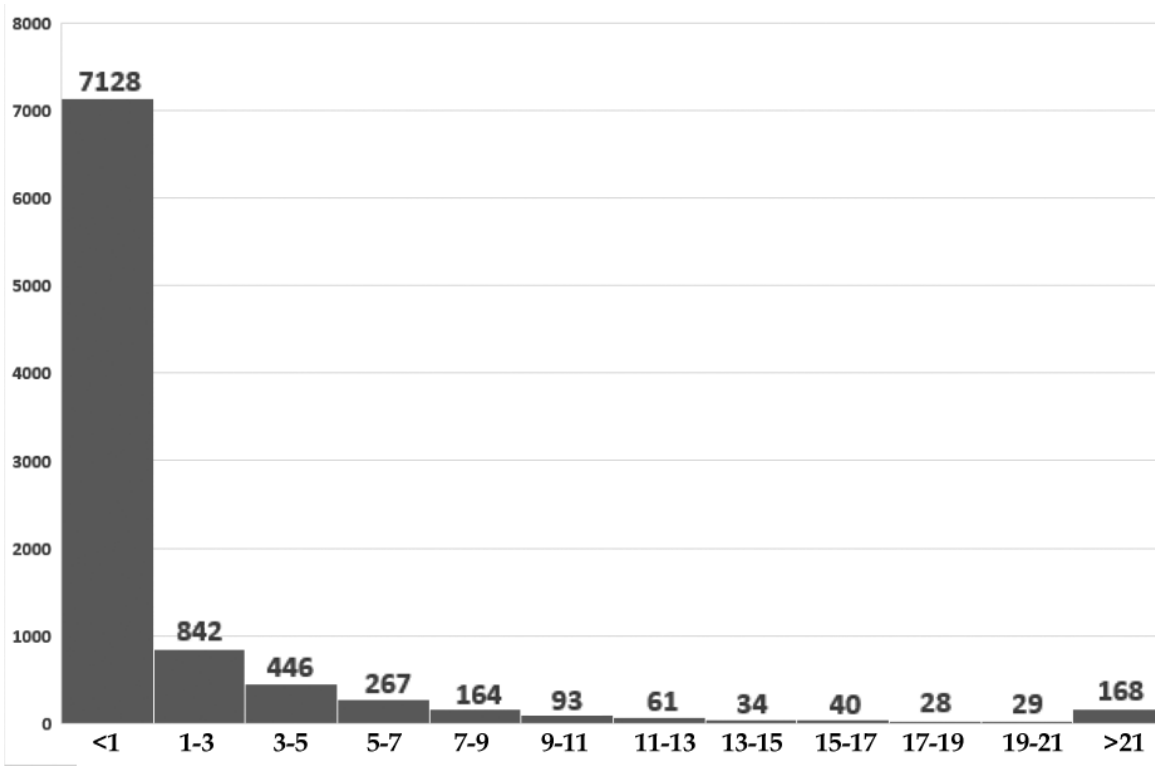
Figure 3. Distribution of the high orbit space objects in the ISON database by the average value of area-to-mass ratio, m 2 /kg (vertical axis - number of objects, horizontal - ratio of area to